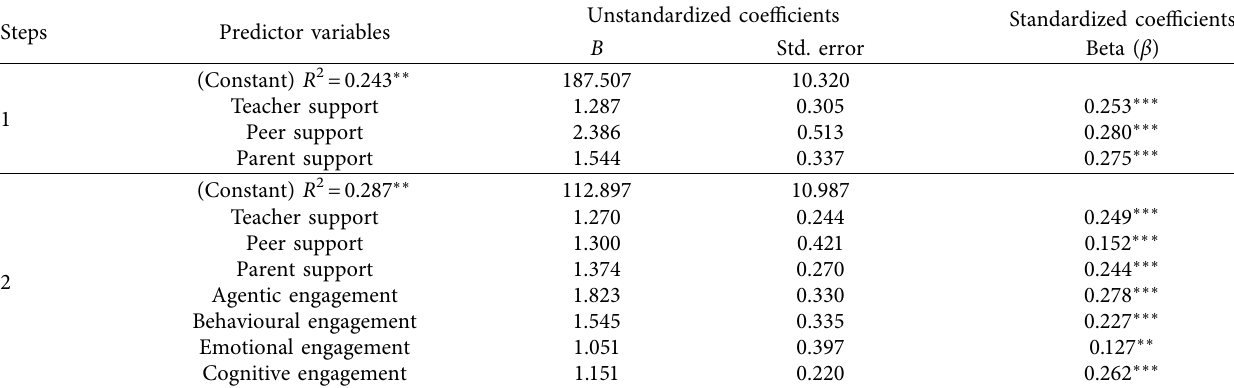
Table 5: Hierarchical regression analysis predicting remedial students’ science success in